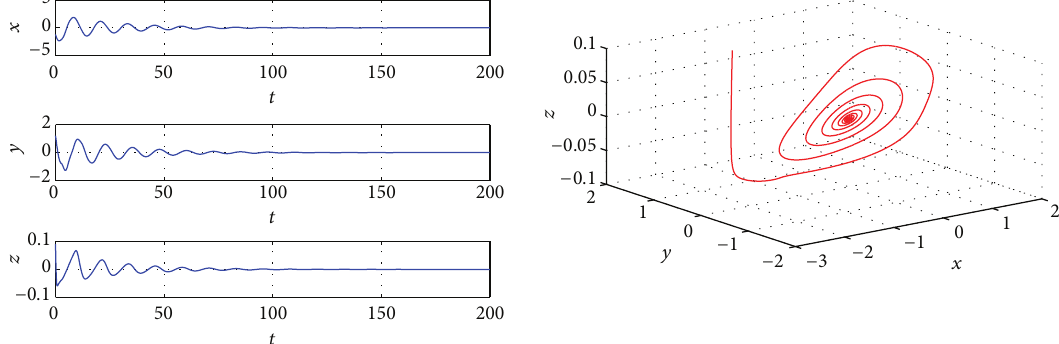
Figure 5: The trajectories and phase graphs of system (61) with 𝜏 = 2.6815 when 𝐾 = −1 .